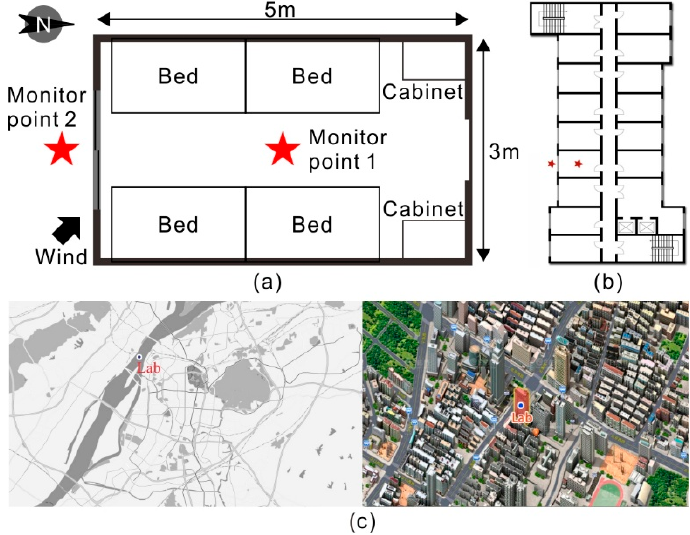
Figure 1. ( a ) A typical student dormitory in China; ( b ) Location floor of the student dormitory; ( c ) Location of the monitored field.